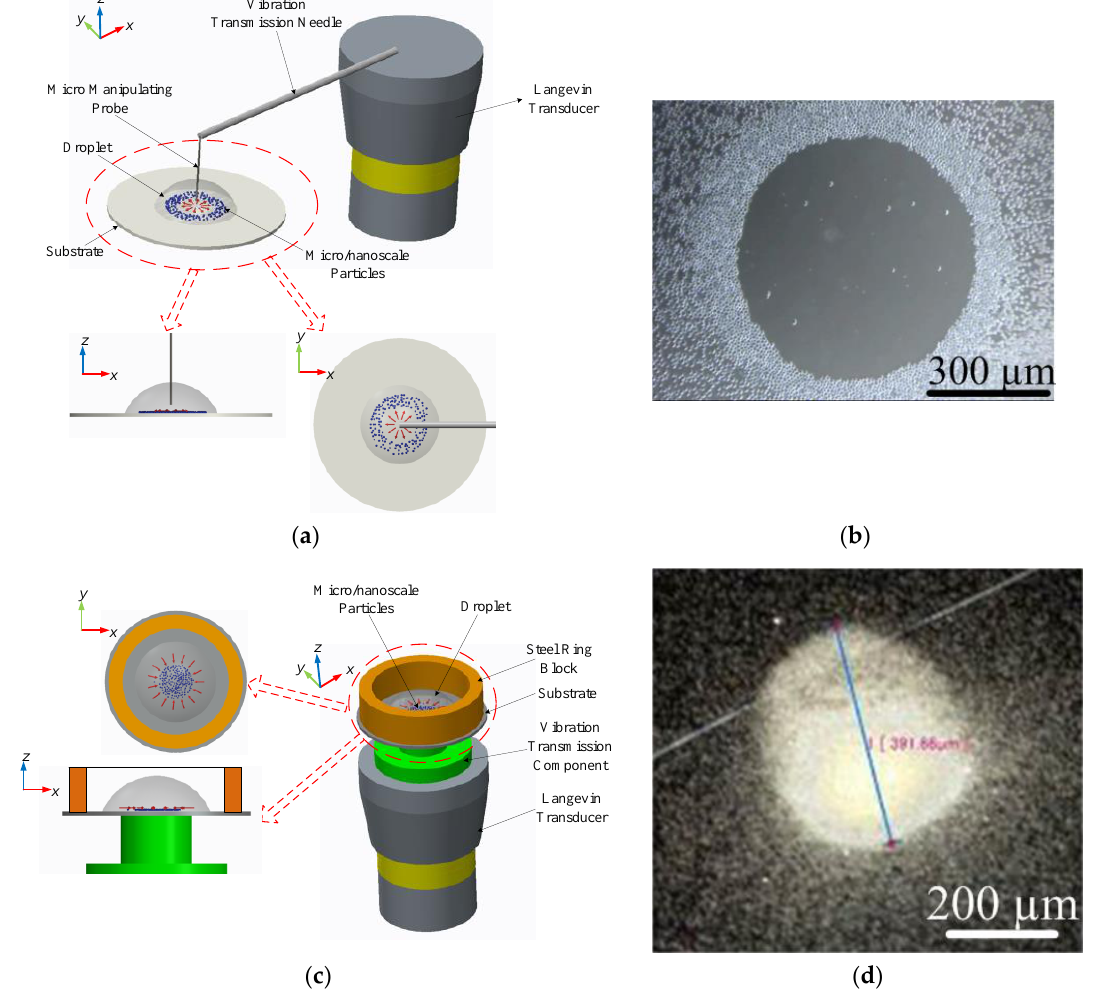
Figure 3. Experimental setups to verify the simulation results. ( a ) Schematic diagram of the ultrasonic probe-droplet-substrate system for micro/nanoscale particle removal. ( b ) Stable removal effect of yeast cells when R = 15 μm, L = 4 mm, V pvib = 0.3 m/s, H = 50 μm and f p = 40 kHz. ( c ) Schematic diagram of the droplet-ultrasonic substrate system for micro/nanoscale particle concentration. ( d ) Stable aggregation of AgNPs when R E = 3 mm, V svib = 10 mm/s and f s = 40 kHz.